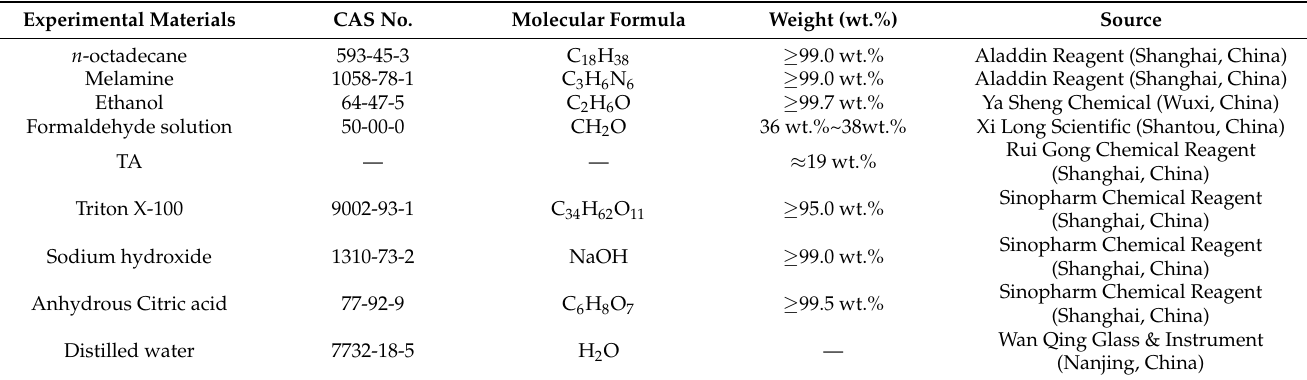
Table 1. Experimental materials used in the preparation of